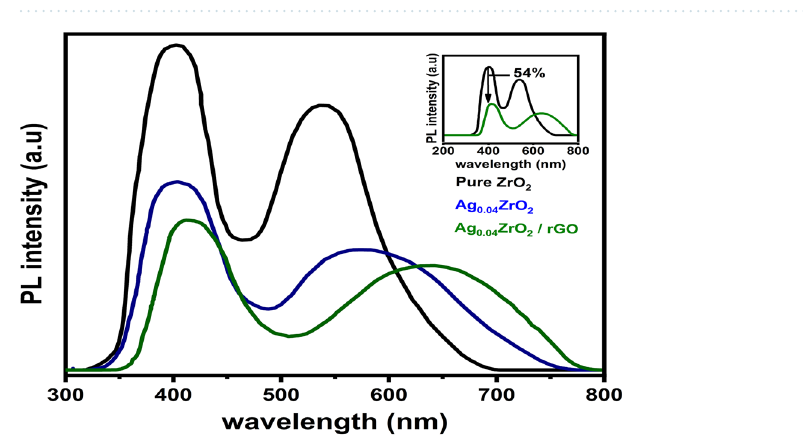
Figure 3. ( a ) UV–Vis DRS spectra of ZrO 2 , Ag 0.04 ZrO 2 , and Ag 0.04 ZrO 2 /rGO photocatalysts. ( b ) Eg of ZrO 2 , Ag